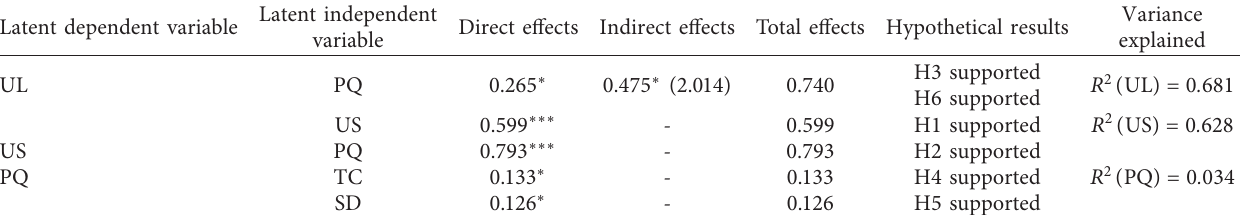
Table 8: Test results of model hypotheses (indirect effects).